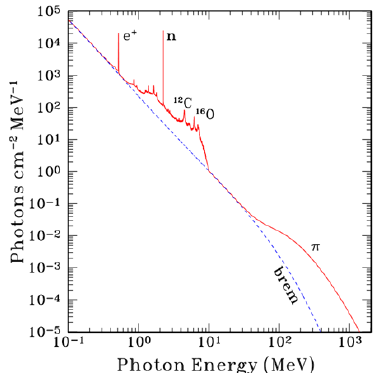
Figure 2. Overall theoretical spectrum of gamma-ray emission from the Sun from 0.1 MeV to 2 GeV. The blue dashed line labeled “brem” represents the contribution from the bremsstrahlung of energetic electrons accelerated during solar eruptions. The red line represents computed spectrum taking into account of all possible processes that contribute to gamma-ray emission. At energies below ~10 MeV there is a quasi-continuum with several lines superposed. e+ and n represent the 0.511 MeV positron annihilation line and the 2.223 MeV neutron capture line. 12 C and 16 O mark the next intense lines produced by nuclear deexcitation. The pion continuum at high energies is denoted by π, which involves contribution from both neutral and charged pions. The energy for these emission components is from energetic particles (electrons and ions) accelerated in the solar corona during solar eruptions (adapted from Ramaty and Mandzhavidze [19]).